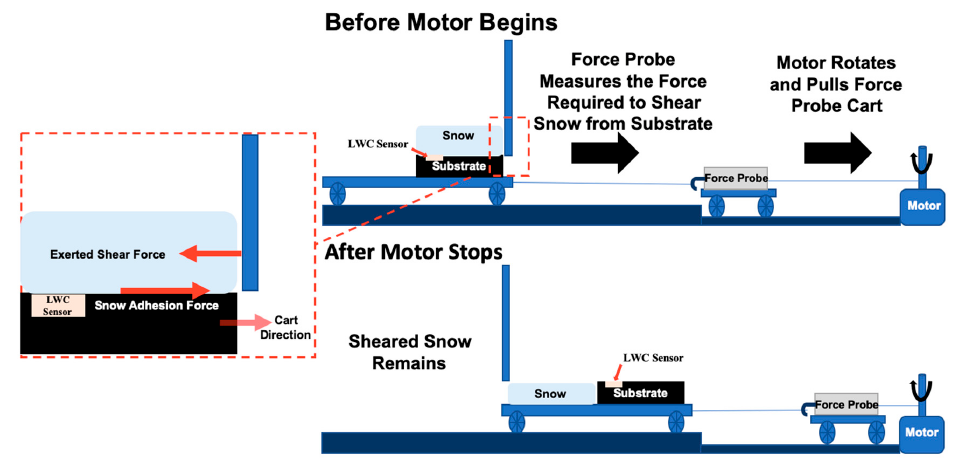
Figure S3 for the photo of the setup). An LWC sensor is centered on the sample furthest from the shear wall. Initially, two sensors were placed on the sample during testing. Once it was verified that the LWC remained unchanged, a single sensor was used to maximize the surface area of the substrate in contact with the snow.